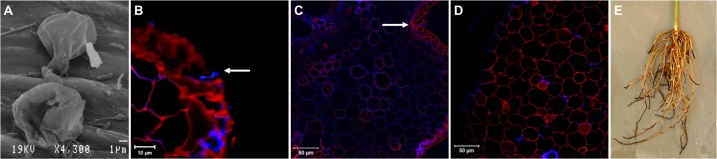
Phytophthora cinnamomi (Pc) infection of resistant avocado roots.A. Scanning electron micrograph of two Pc cysts germinating, with hyphae entering the root at the same site via direct penetration 1 hpi. B. Confocal image of Pc hyphae (white arrow) penetrating through the root epidermis at 3 hpi. C. Confocal image of lignified root cortex cells with hyphae (white arrow) at 12 hpi. D. Confocal image of root cortex cells demonstrating extensive lignification at 24 hpi. E. Brown necrotic lesions are visible on avocado roots six weeks after Pc inoculation.